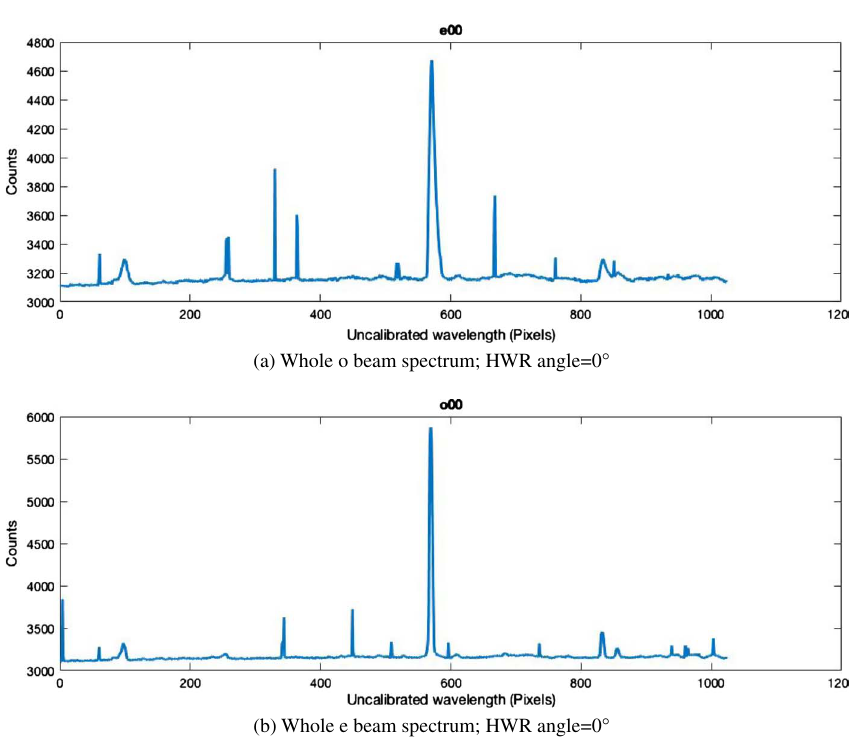
Fig. 5. Raw whole spectra for the data set taken March 2nd 2017 from 19:35 to 20:20. Calibration in wavelength is not shown since it is notused in the data processing once the blue line have been locate. Both o (Left panels) and e (Right panels) beams are shown at HWR position 0 (cid:3)